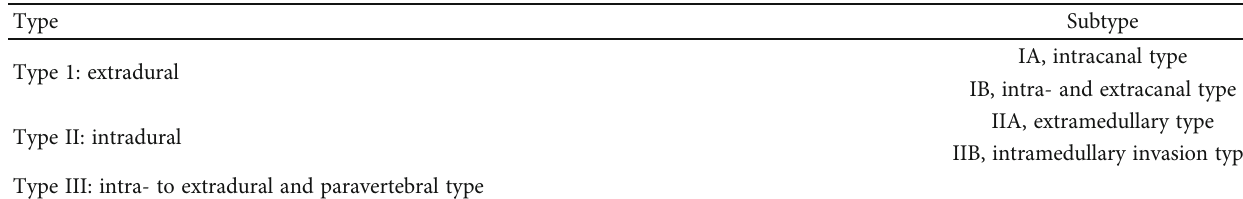
Table 2: Liu classi fi cation for localization of spinal SFTs